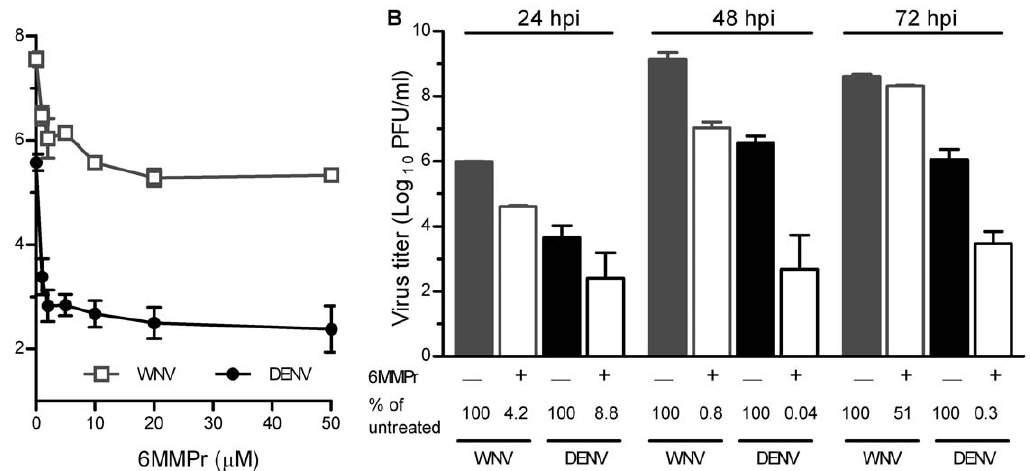
Figure 2. 6MMPr inhibited DENV production to a greater extent than WNV production. Vero cells were inoculated with WNV or DENV-2 (New Guinea C) in the presence of 6MMPr at (A) various concentrations or at (B) 10 m M. Medium was harvested at (A) 48 hpi or (B) various times pi, and viral titers were determined by plaque assays. At least two independent experiments were performed, and the means 6 standard deviations from one experiment, performed in (A) sextuplets or (B) triplicates, are shown. The antiviral effects on WNV and DENV-2 were compared at each concentration of 6MMPr in (A), and P values were # 0.005 at all concentrations tested (1–50 m M).